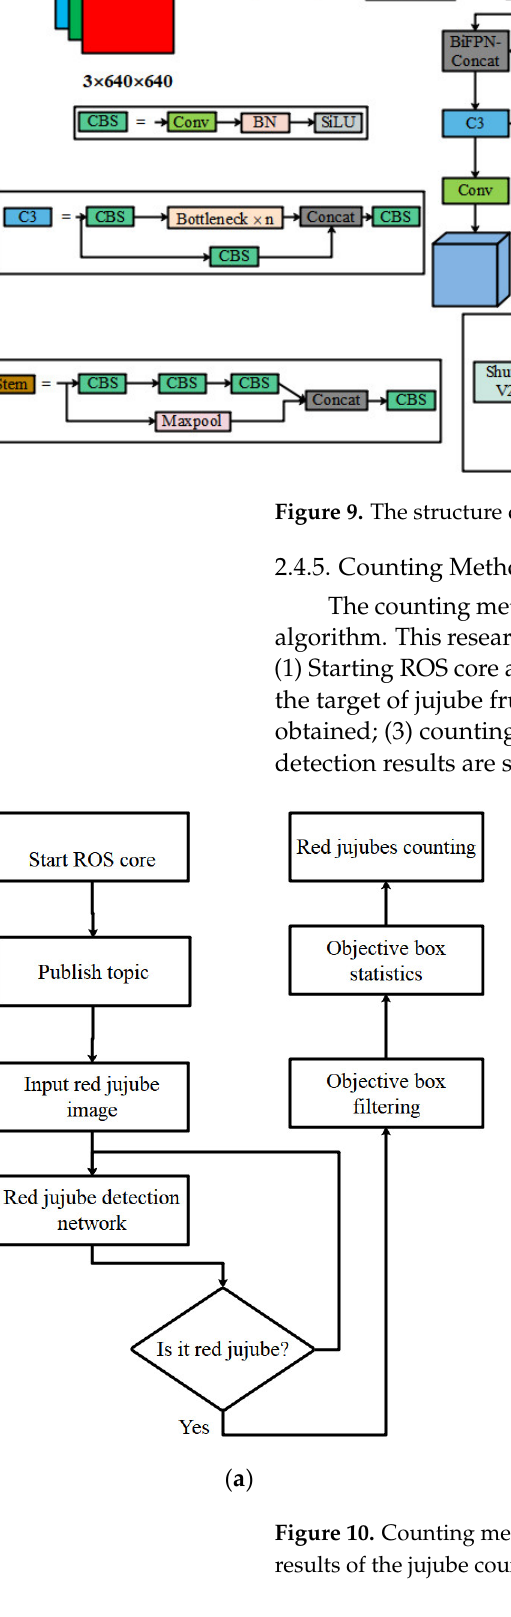
10 of 20 Figure 8. bi-directional feature fusion network. ( a ) PANet with bi-directional feature fusion net- work, ( b ) BiFPN with bi-directional feature fusion network. In this research, BiFPN was introduced in the neck of YOLOv5s, as shown in Figure 9. Because the node, which had only one input edge and no ability of feature fusion, made little contribution to the feature fusion of the network. Therefore, deleting this node had